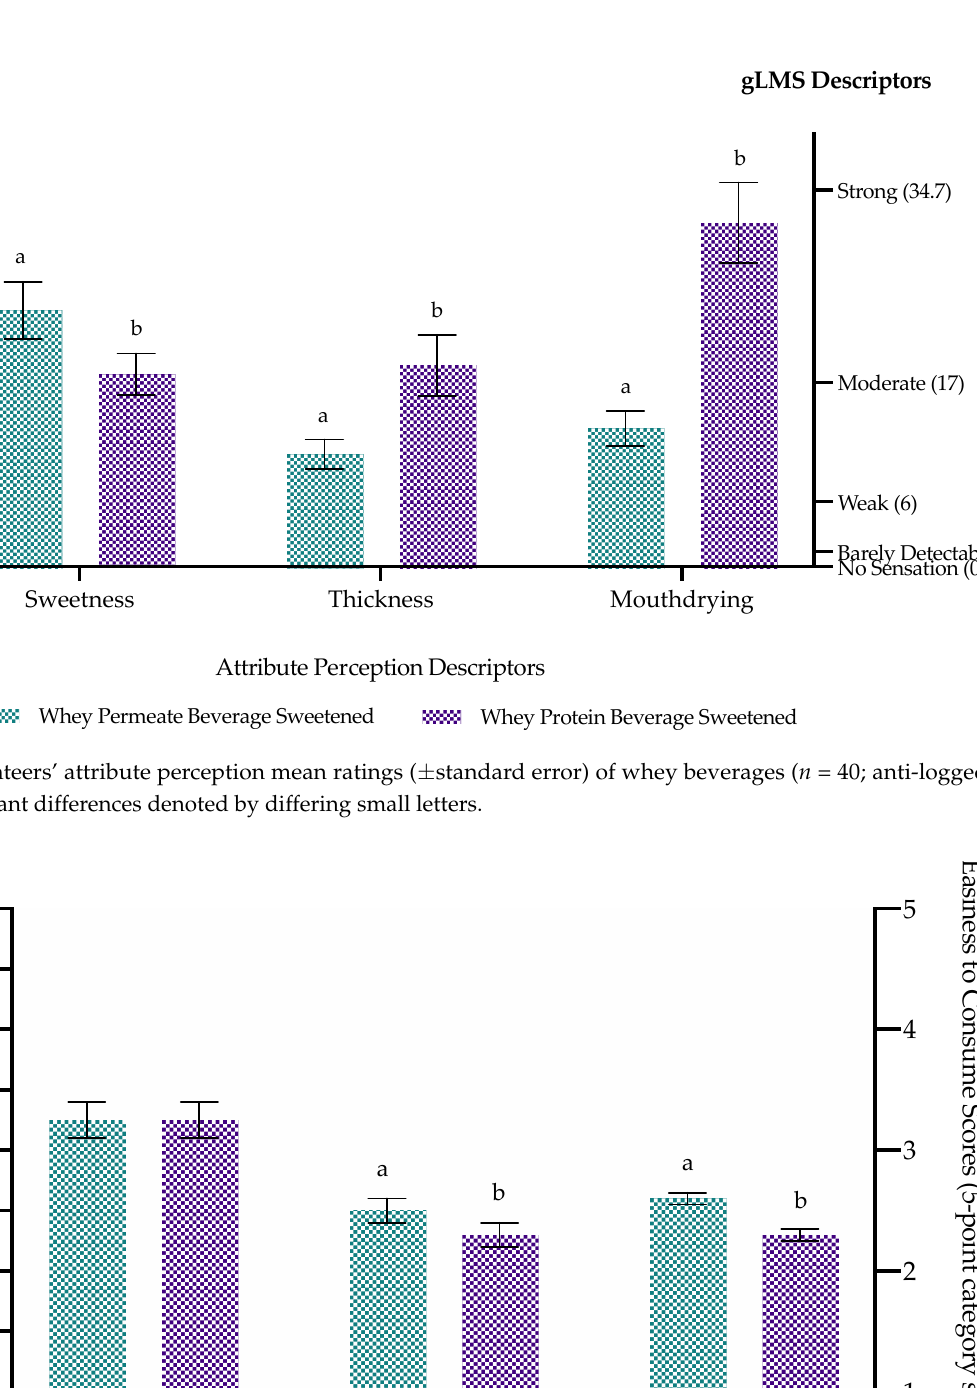
10 of 19 Table 4. Mean Just-About-Right (JAR) ratings and subsequent influence on liking ratings (penalty analysis) (WPeBS: whey permeate beverage sweetened; WPBS: whey protein beverage sweetened). Overall ( n = 40)